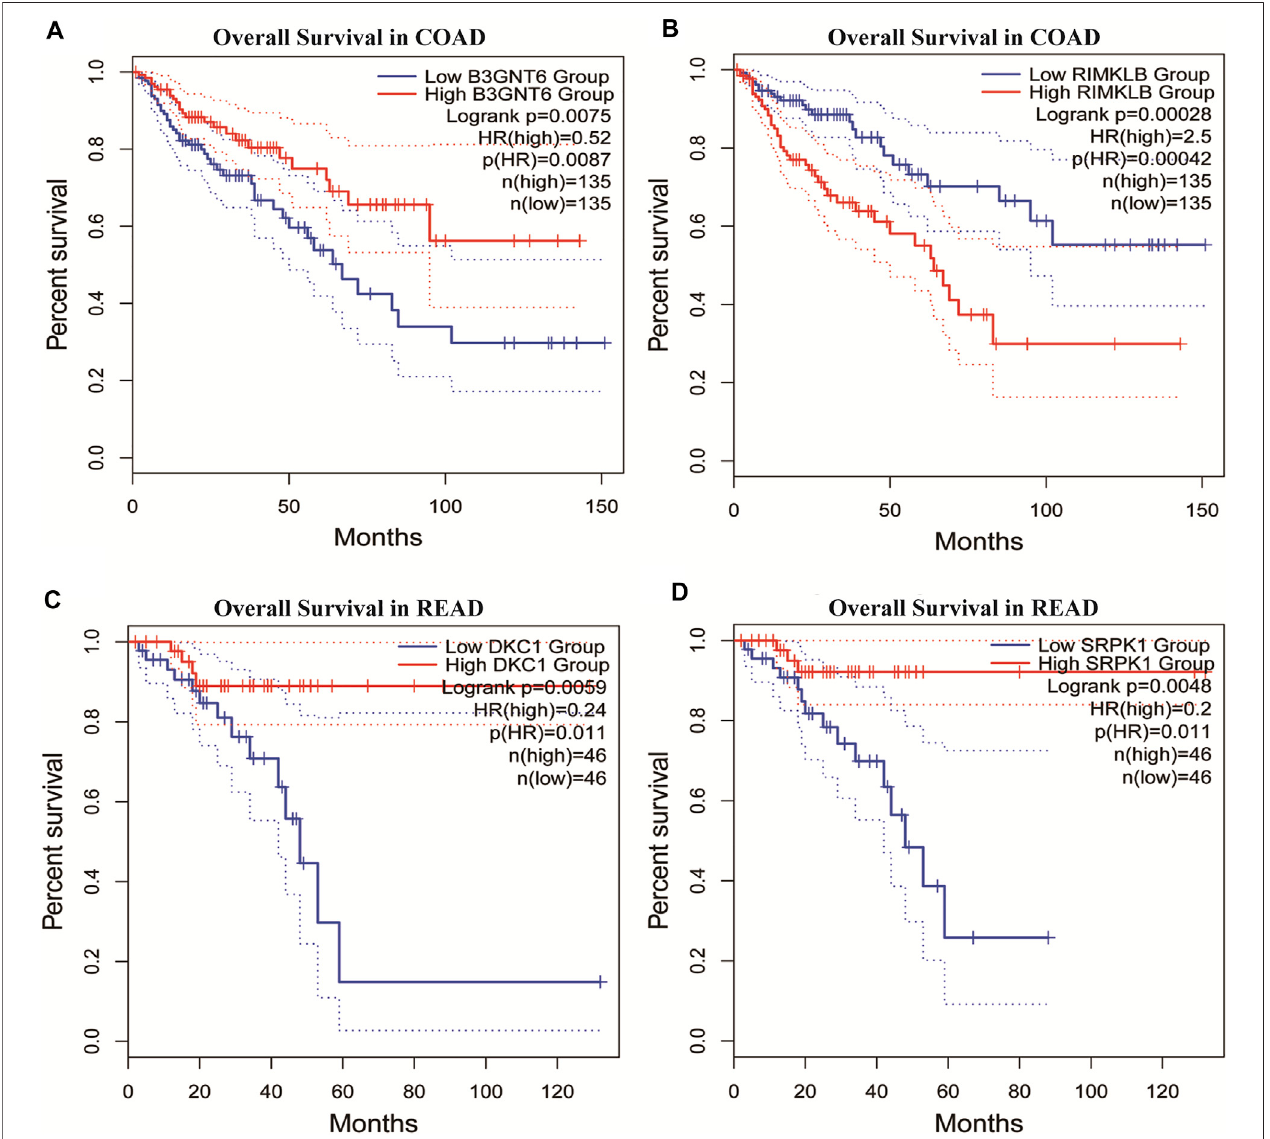
FIGURE 5 | Survival analysis of differentially methylated and differentially expressed genes. (A,B) Survival analysis of B3GNT6/RIMKLB in COAD. (C,D) Survival analysis of DKC1/SRPK1 in READ. (COAD: colon cancer; READ: rectal cancer).